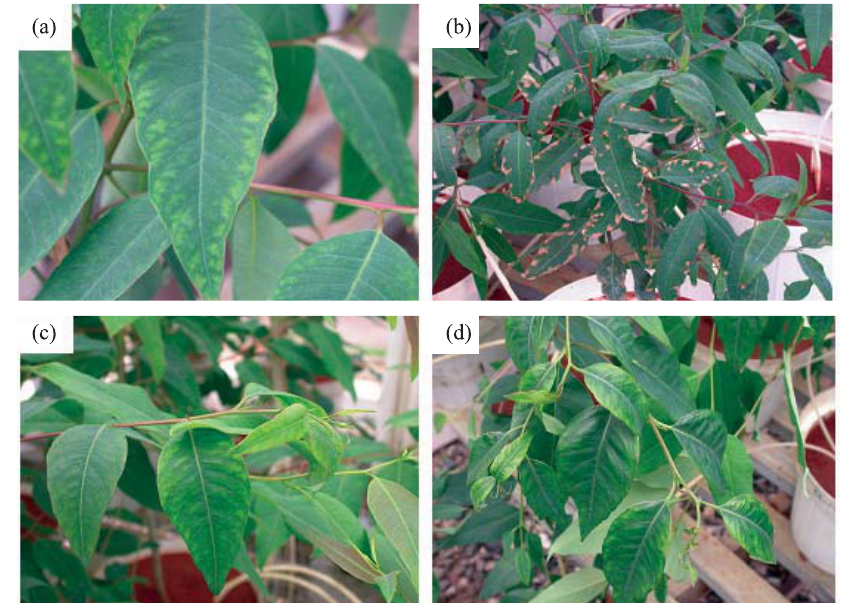
Figura 1. Estádio inicial e mais avançado de toxidez e deficiência de B em eucalipto. (a) toxidez inicial; (b) toxidez avançada; (c) deficiência inicial; e (d) deficiência mais avançada.